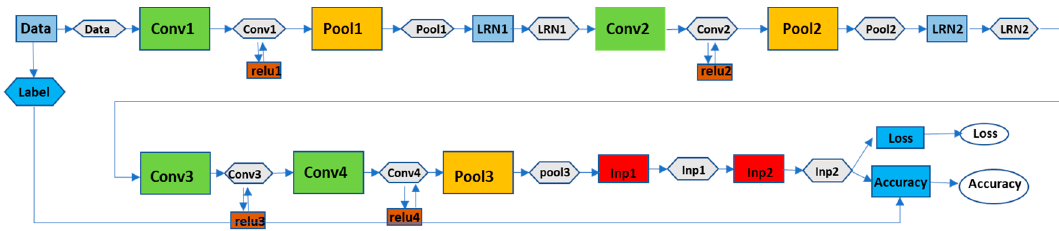
Figure 9. CNN’s architecture (our own redrawing), conformed by four convolutional layers, three pooling layers, two normalization layers and two fully-connected layers at the end [39].